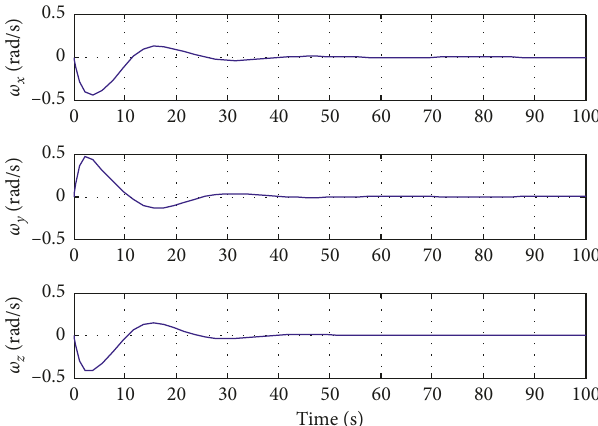
Figure 1: Time response of angular velocity w when Φ � 200 ∘